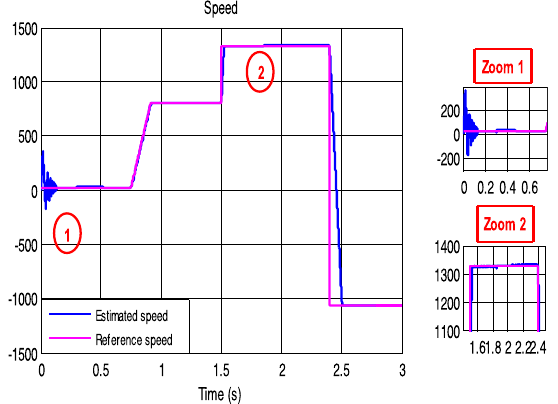
Fig. 11 PI-DTC-SPWM with three-level inverter estimated speed